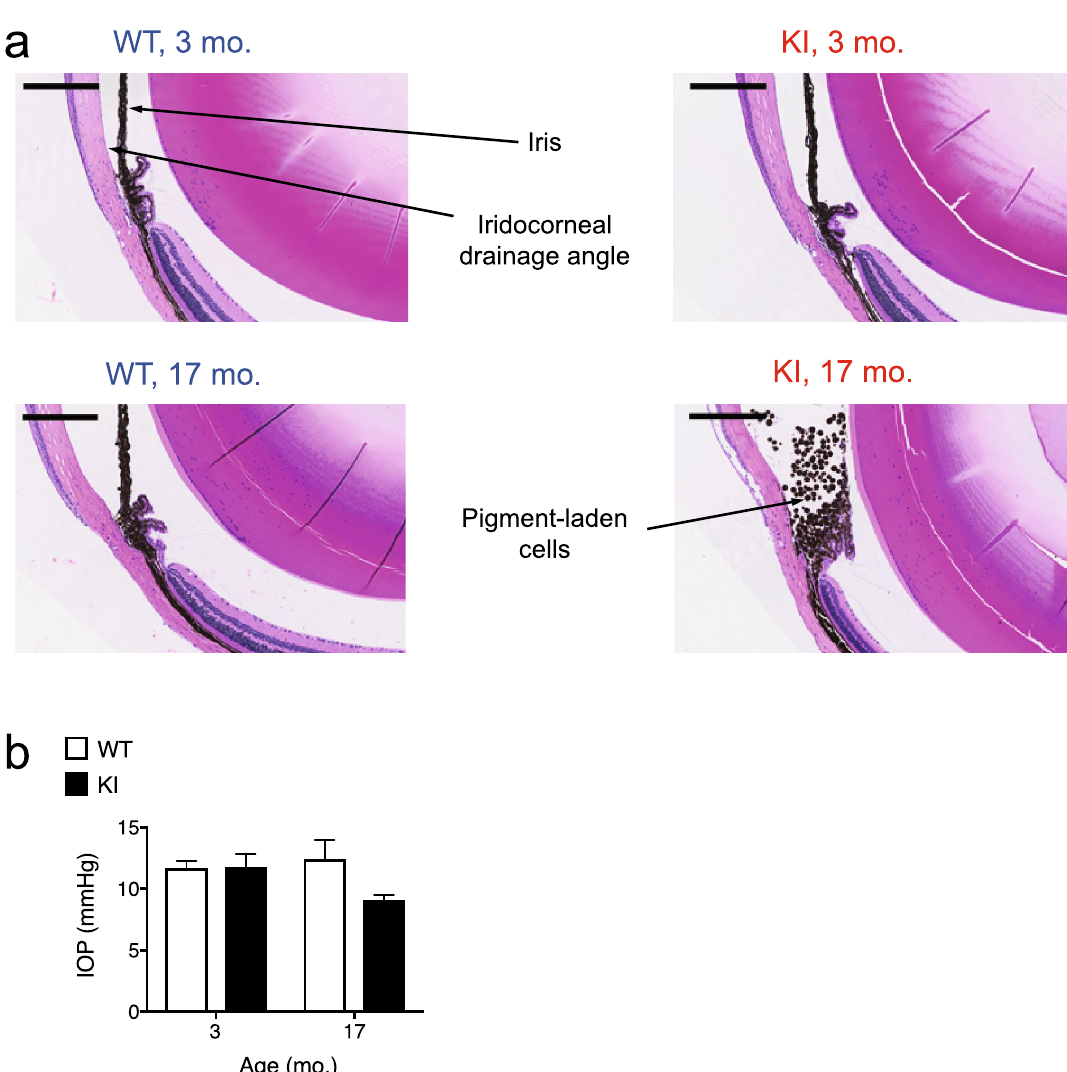
Figure 5. Pigment-laden cells occluding the iridocorneal in aged Gba KI mice. ( a ) Representative images taken from sagittal sections through the globe at the level of the optic nerve at higher magnification in 3- versus 17-months old Gba KI and WT mice. In aged Gba KI mice (bottom right), sheets of pigment-laden cells are occluding the iridocorneal angle, a component of the draining system allowing for the outflow of aqueous humor, consistent with an open-angle glaucoma-like phenotype. This phenotype was significantly more frequent in aged Gba KI mice (Supplementary Table S3). ( b ) IOP measures were conducted in anesthetized 2- and 17-months old mice using rebound tonometry. The scale bar denotes 200